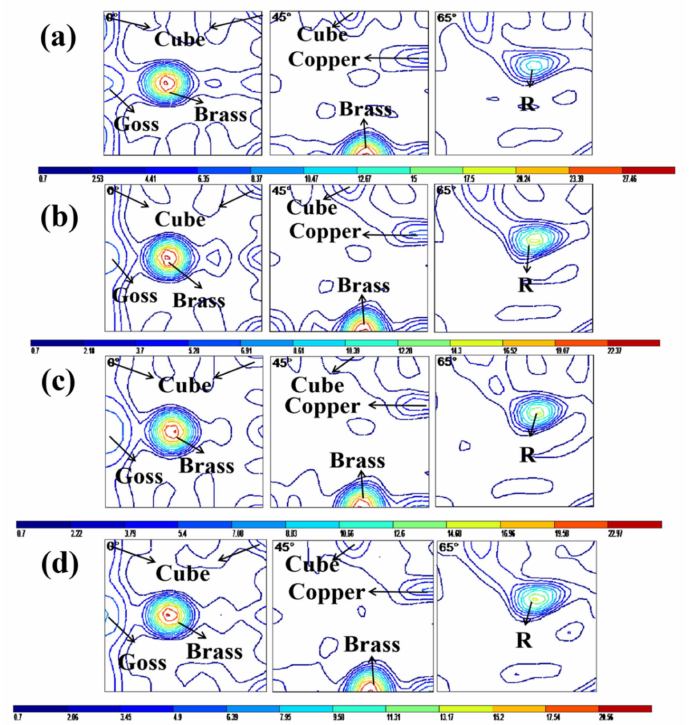
Figure 6. ODF results of the 25 mm hot rolled plate after solution at 477 ◦ C for: ( a ) 30 min, ( b ) 90 min, ( c ) 210 min, ( d ) 330